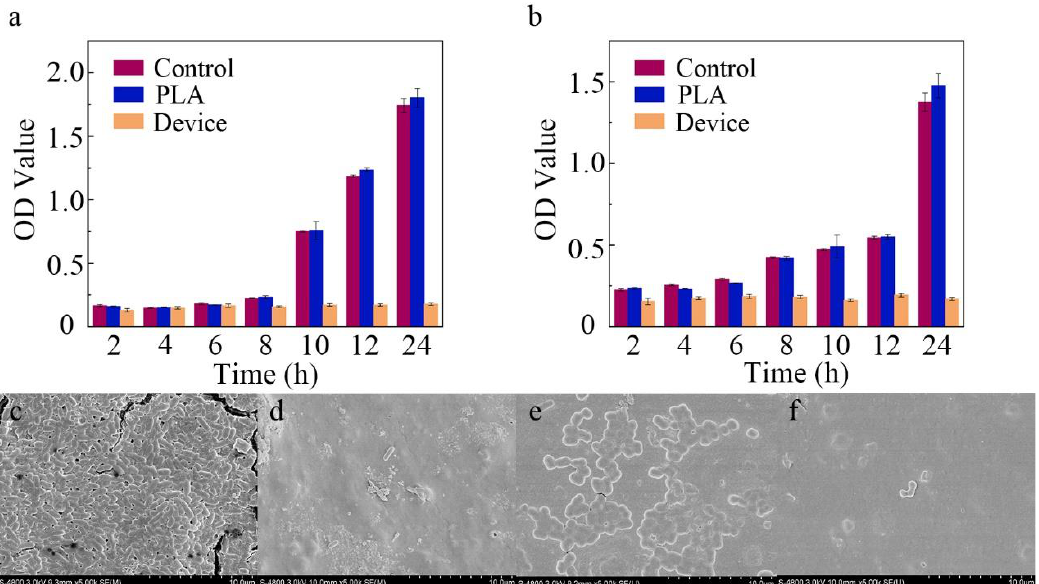
Figure 6. Characterization of antibacterial activity. ( a ) The OD value of E. coli after 24 h. ( b ) The OD value of S. mutans after 24 h. ( c ) SEM image of PLA substrate surface with E. coli . ( d ) SEM image of microfluidic/chitosan device surface with E. coli . ( e ) SEM image of PLA substrate surface with S. mutans . ( f ) SEM image of microfluidic/chitosan device surface with S. mutans .